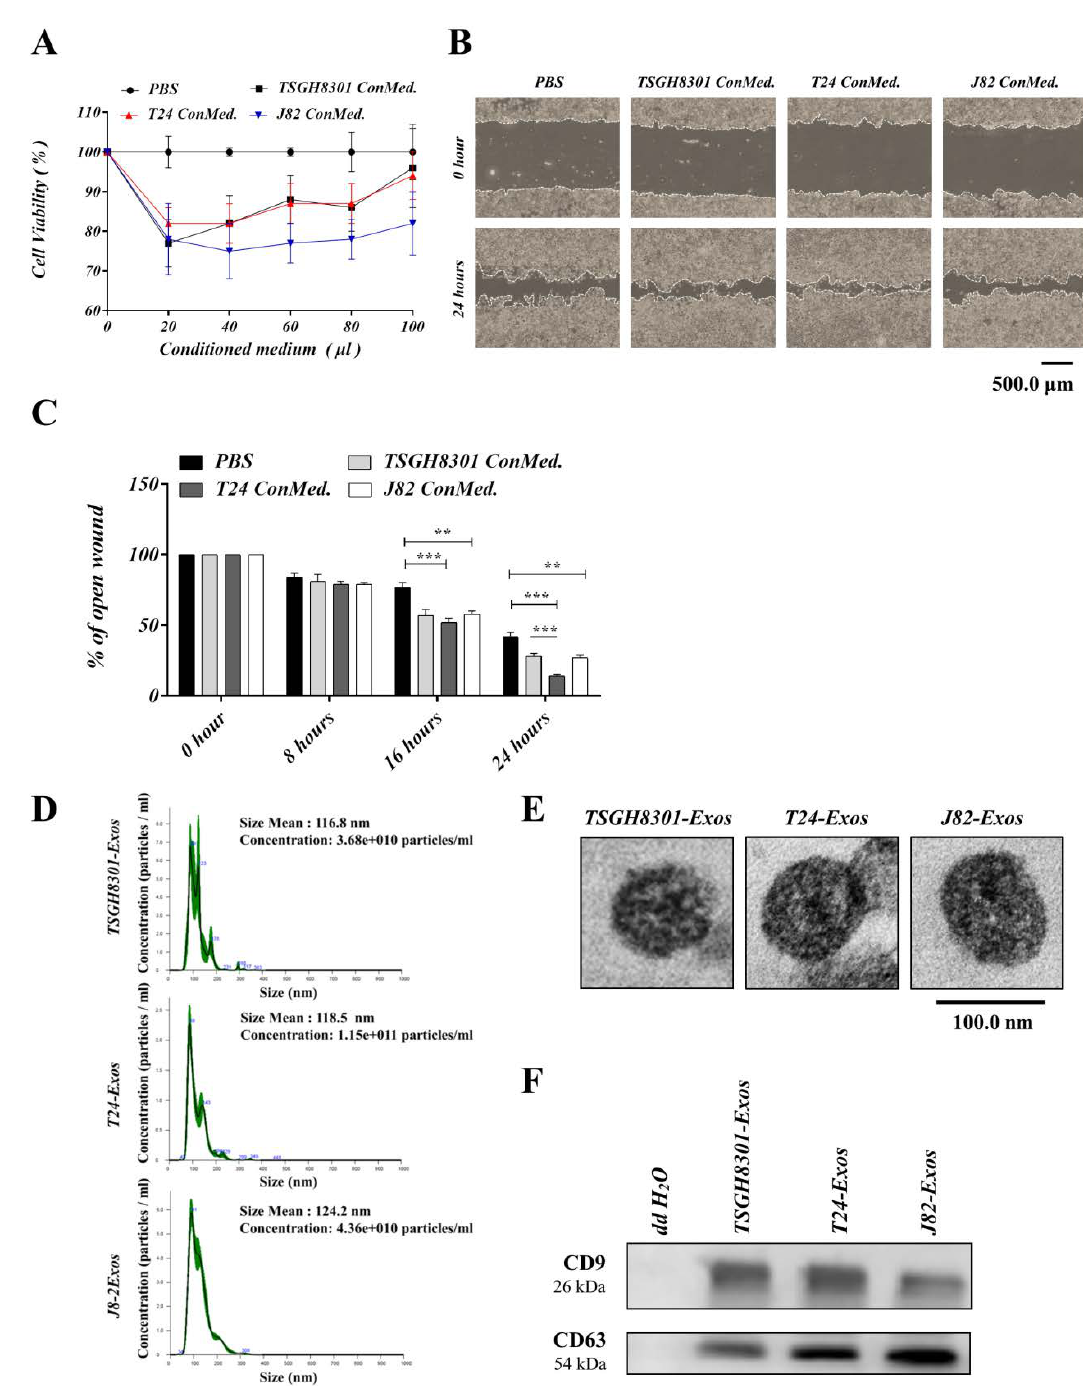
Figure 1. Conditioned medium of high-grade bladder cancer cells increased viability and motility of low-grade bladder cancer cells. ( A ) Cell viability was compared using MTT assays in TSGH-8301 cells treated with the indicated conditioned medium, * p < 0.05, ** p < 0.01, *** p < 0.001. ( B ) The wound healing assay demonstrated that conditioned medium increased the migration of TSGH-8301 cells. Wound areas were measured at 0, 8, 16, and 24 h after scratching, and the representative images were shown at 0 h and 24 h after scratching. The wound closure distance was measured with the ImageJ software. The bars represent the mean and SD of three independent experiments, * p < 0.05, ** p < 0.01, *** p < 0.001. ( C ) Nanoparticle tracking analysis was used to compare the average size of isolated exosomes. ( D ) Transmission electron microcopy was used to observe the morphology of